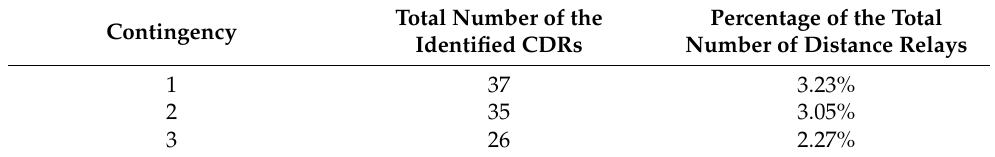
Table 8. The total number of the identified CDRs.